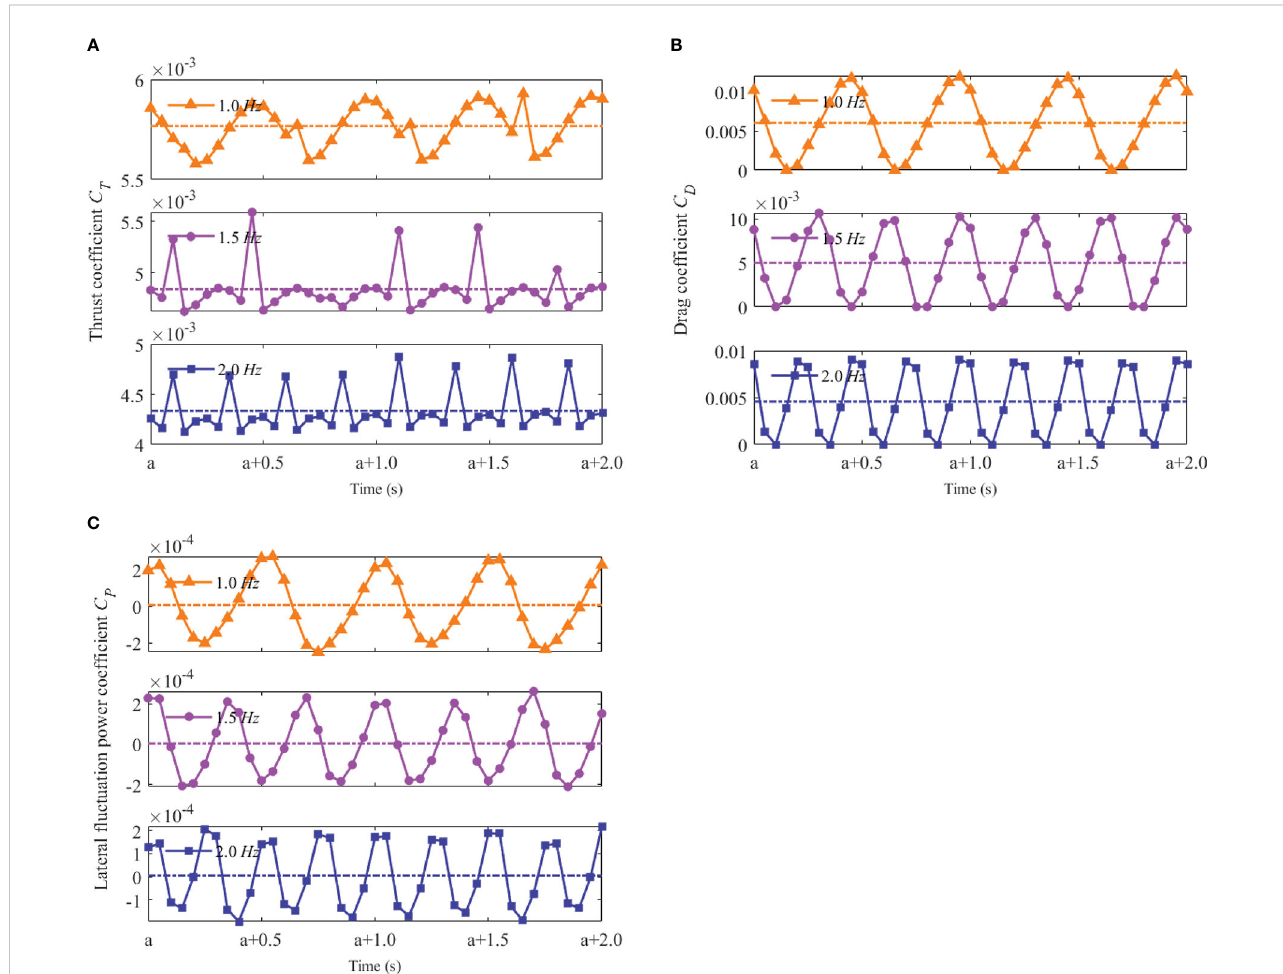
FIGURE 11 Hydrodynamic coef fi cients of the swimmer at different tail-beat frequencies f (A) Thrust coef fi cient C T (B) Drag coef fi cient C D (C) Lateral fl uctuation power coef fi cient C p.